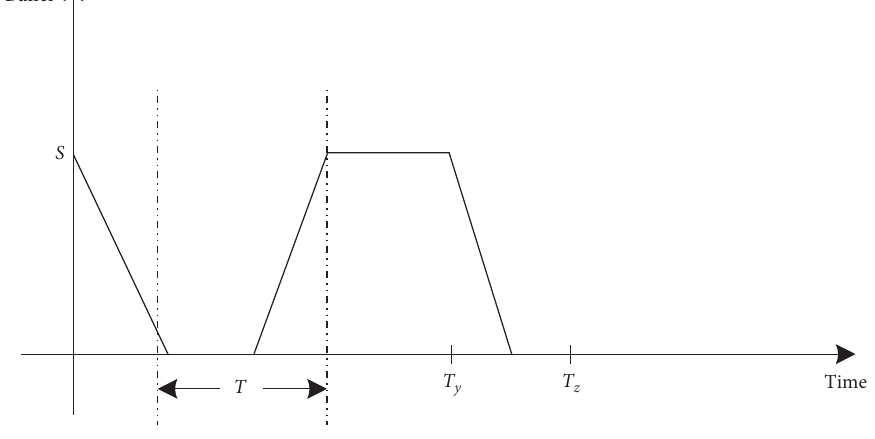
Figure 10: Buffer stock change diagram in a cycle for 0 < T < T